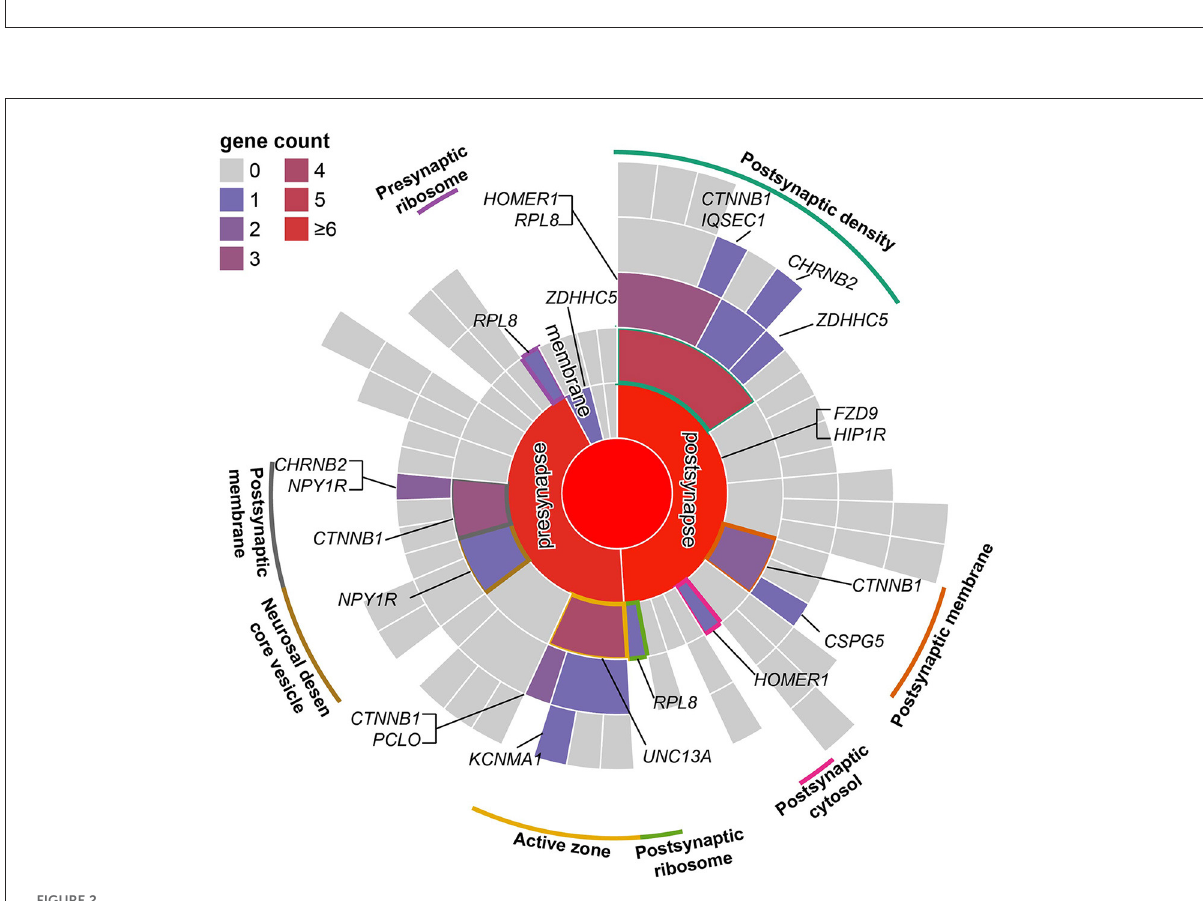
FIGURE2 Mapping of SMR risk genes to synaptic locations using SynGO. According to the location of genes in the synapse, genes were divided into presynaptic, postsynaptic, synaptic cleft, synaptic membrane, and extrasynaptic genes. Similar to a directed acyclic graph of GO, terms in the outer ring are a subset of those in the adjacent inner